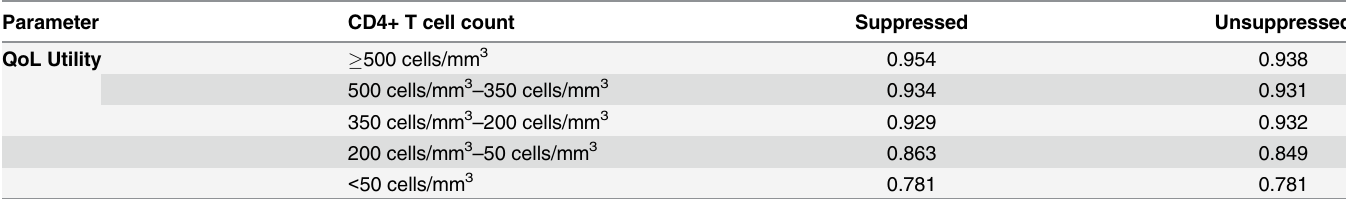
Table 6. Quality of life utilities for cost-effectiveness modeling.